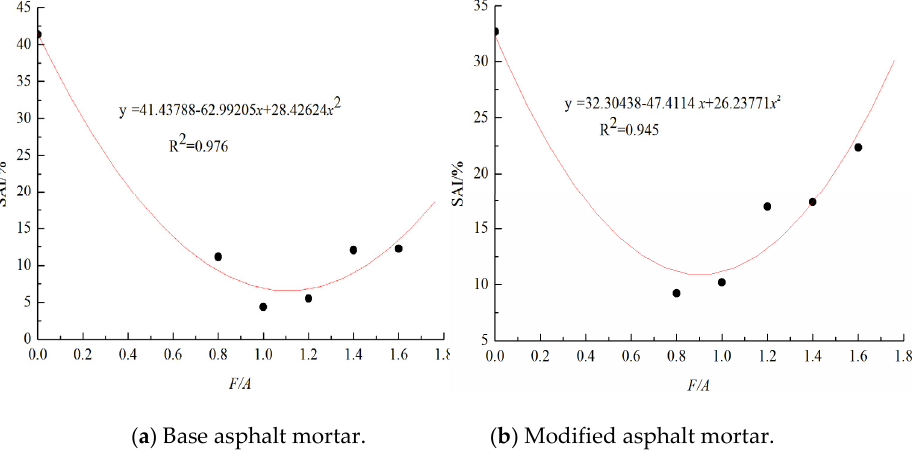
Figure 15. Creep stiffness factor aging index about these different types of asphalt mortar.